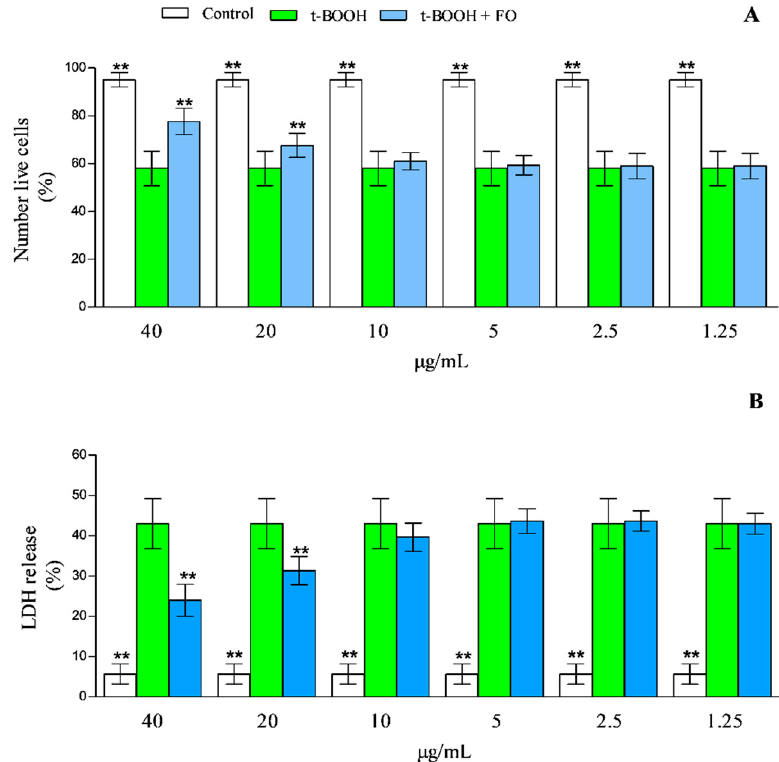
Figure 5. Cytoprotective effects of feijoia EO on t-BOOH treated lymphocytes. Lymphocytes plus 100 μ M of t-BOOH have been incubated for 24 h in the absence or in the presence of 100, 75, 50, 25, and 10 μ g/mL of feijoia EO. Cell viability and integrity have been analyzed by trypan blue staining ( A ) and LDH release ( B ). The presence of asterisks (**) is indicative of significant differences ( p < 0.05) of the sample vs t-BOOH-treated one. Each value represents mean ± SD of three independent experiments ( n = 3).